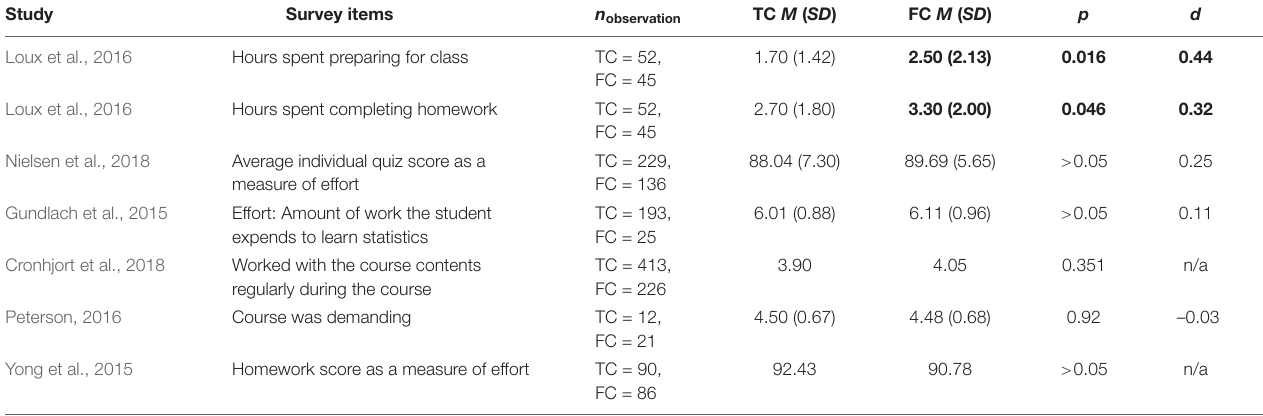
TABLE 3 | Survey results: Effort by effect size.